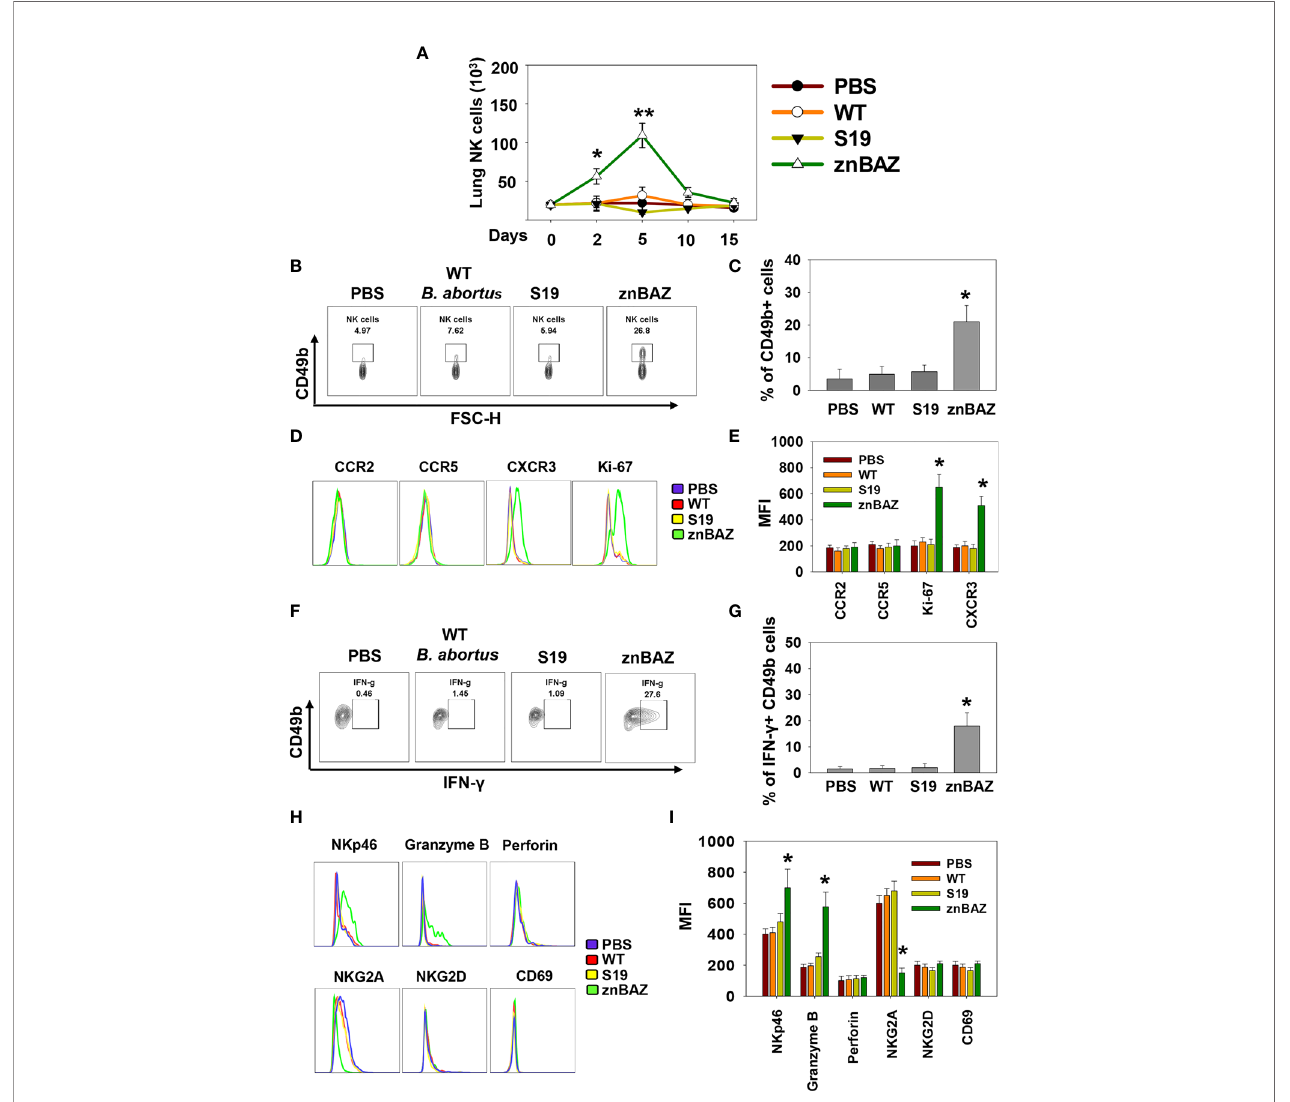
FIGURE 1 | Nasal znBAZ infection promotes lung NK cell expansion. Groups of BALB/c mice were nasally infected with wild-type (wt) B. abortus 2308 (1×10 5 CFUs), B. abortus S19 vaccine (1×10 8 CFUs), or znBAZ (1×10 9 CFUs). (A) Lung NK cell numbers were measured at the indicated days post-infection. (B, C) Flow cytometry analysis of NK (gated on TCR b - CD49b + ) cells on day 5 post-infection, and examined for (D, E) CCR2, CCR5, CXCR3 and Ki67 expression. (F, G) On day 3 post-infection, expression of IFN- g -producing lung NK cells is depicted. (H) Lung NK cells for (top row) NKp46, granzyme B, perforin, (bottom row), NKG2A, inhibitory molecule, NKG2D, and CD69, and their respective (I) MFIs are shown. The data depict the means ± SEM of 5 mice/group; *p < 0.01 and **p ≤ 0.001, compared with PBS-dosed mice. Data are representative of two